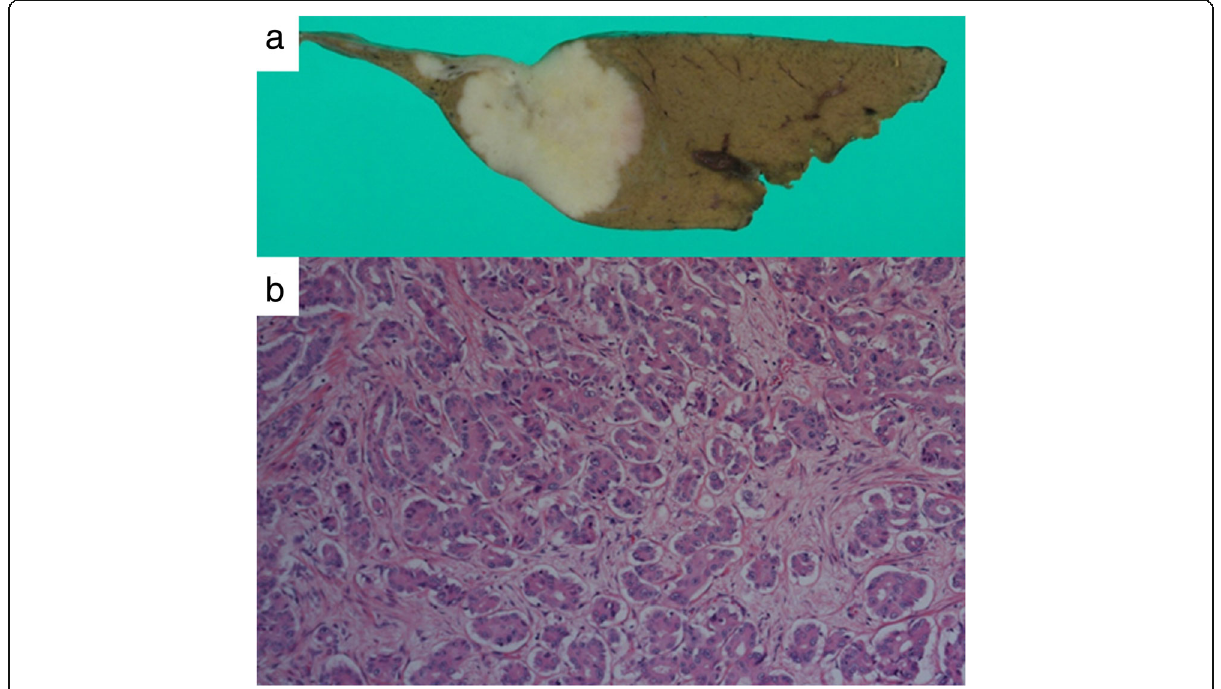
Fig. 2 a The cut surface of the resected specimen shows a gray-white nodular lesion. b Microscopic finding shows moderately differentiated adenocarcinoma in S2 of the liver